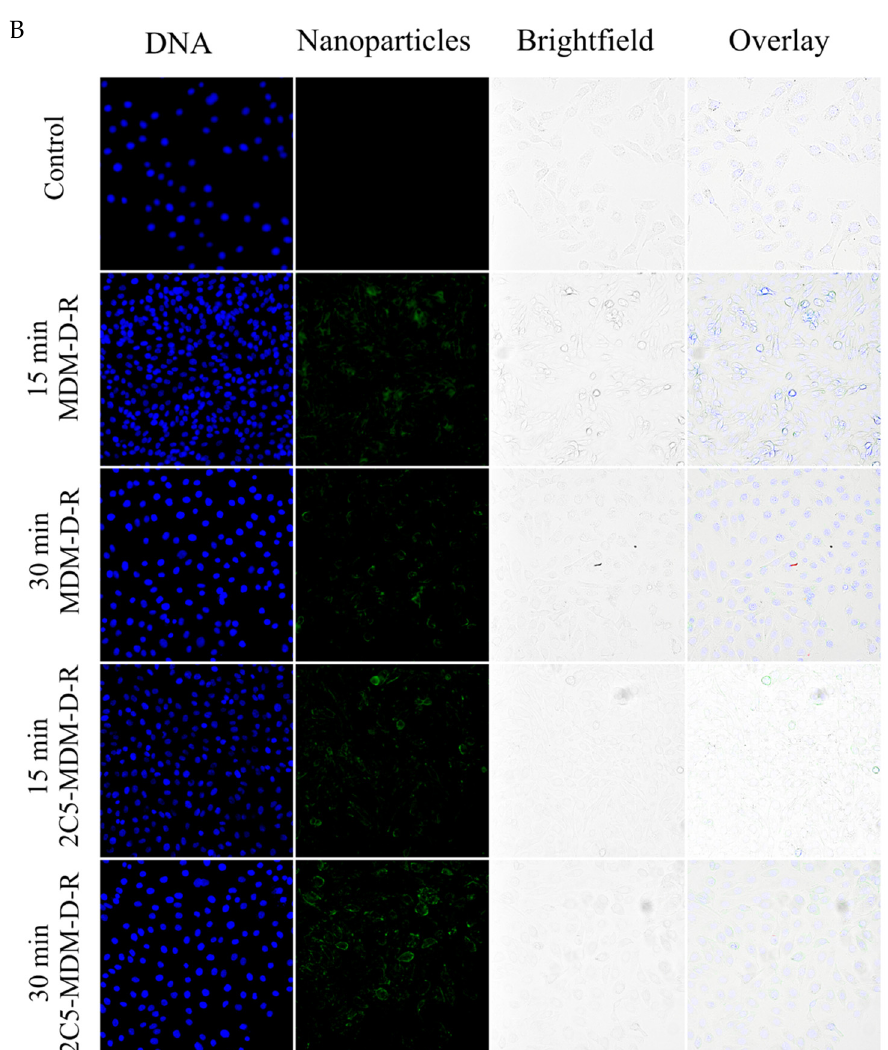
Figure 3. Cellular association of 2C5-modified and non-modified nanoparticles. The figure shows the Hoechst-stained nuclei with carboxyfluorescein-labelled nanoparticles, along with brightfield and overlay images. The carboxyfluorescein-labelled nanoparticles were incubated with ( A ) MDA-MB-231 cells and ( B ) SKOV-3TR cells for 15- and 30-min to observe a greater cellular association (greater green fluorescence) in the 2C5-modified dendrimer micelles in comparison to non-modified micelles. (Magnification 40×).